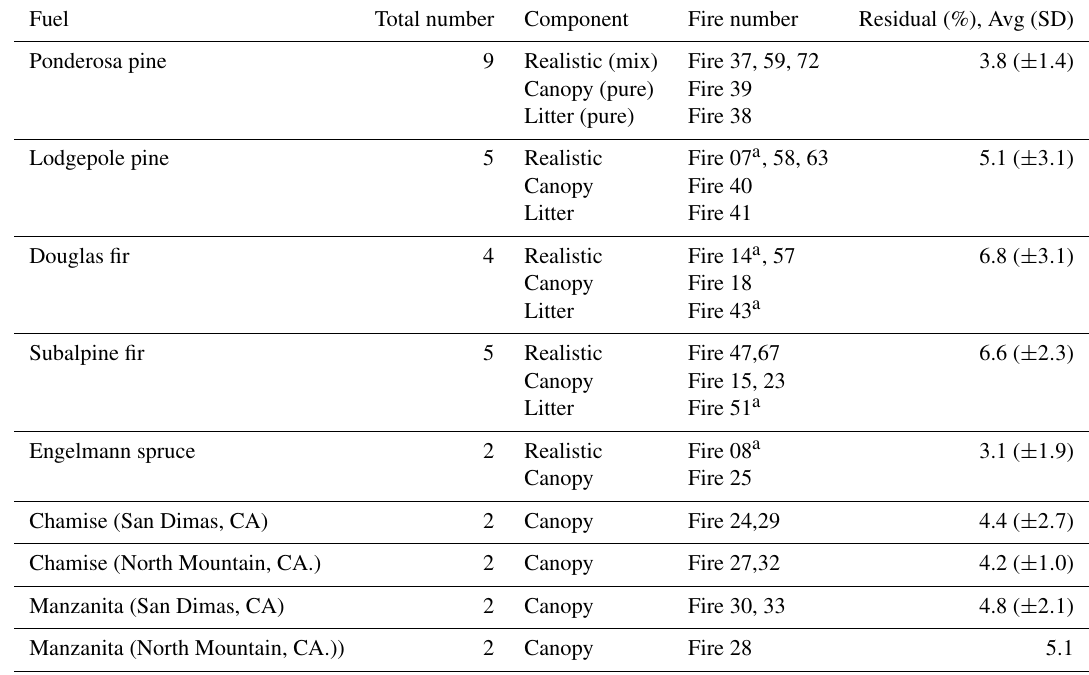
Table 4. Residuals of the PMF analyses by fuel, as percent of total signal.